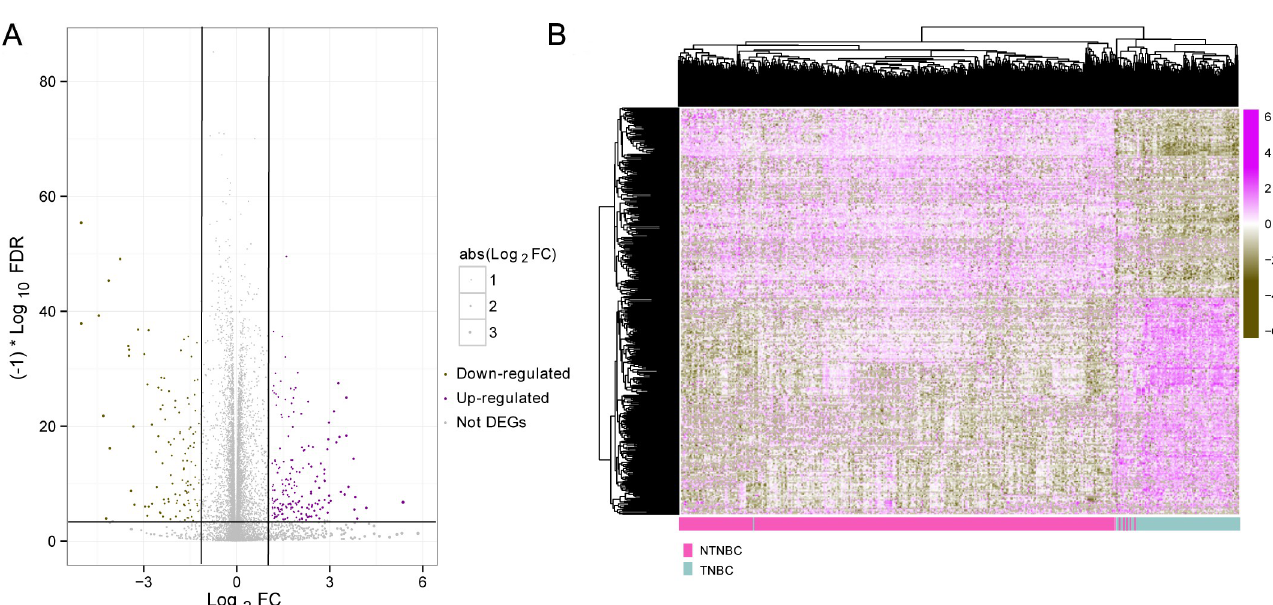
cation on TNBC and NTNBC patients (Fig 1B). A total of 164 DEGs involved in both AmiGO2 and KEGG databases were used for further study (S3 Table).